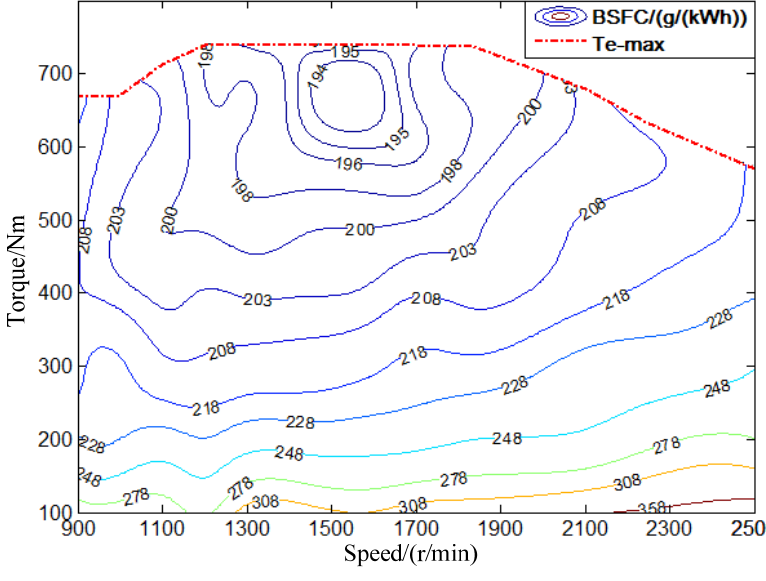
Figure 4. The ICE fuel consumption